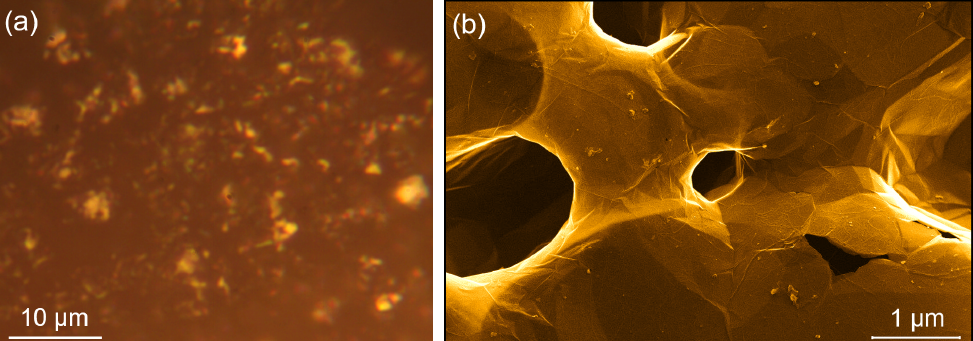
Figure 2. ( a ) Optical image of the NPG sample acquired with a 100 × magnitude objective. ( b ) Scanning electron microscopy (SEM) image of the NPG sample, showing the presence of pores several hundreds of nanometres in size and the continuous structure of the graphene